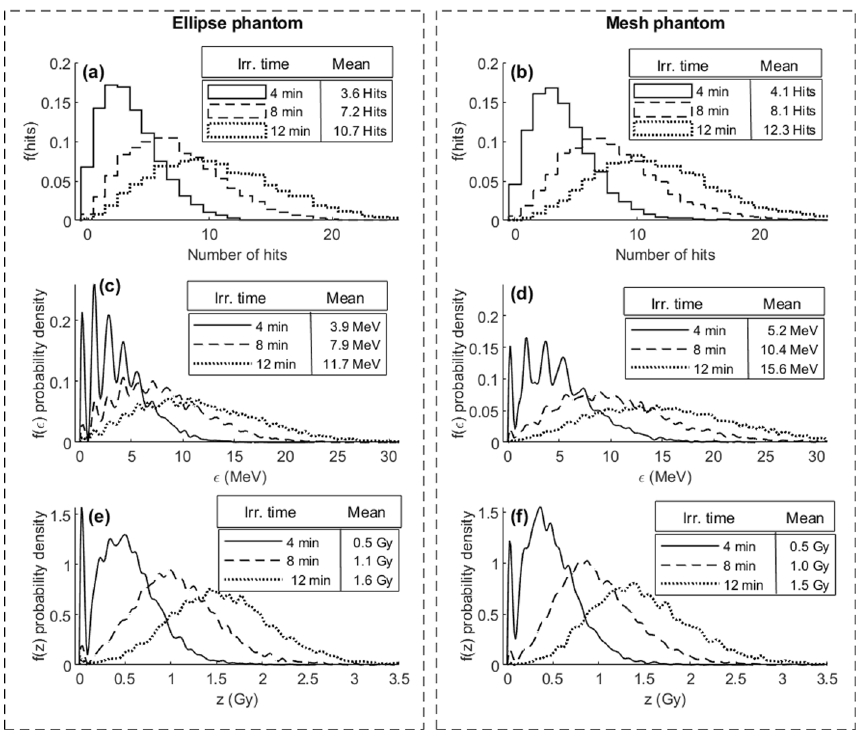
Fig. 5 Simulation results for elliptical cylinder phantom (left panel a , c , e ) and the mesh volume phantom (right panel b , d , f ) figured as probability density functions (PDFs). The number of alpha particle hits per cell nuclei, f(hits), in a and b , the energy imparted per cell nuclei PDF, f(ε) in c and d , and the specific energy per cell nuclei PDF, f(z), in e and f for respective